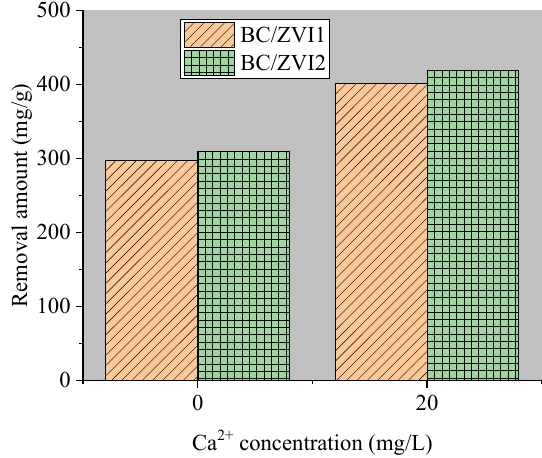
Figure 8. Effect of tert-butanol on TC removal efficiency of three materials.